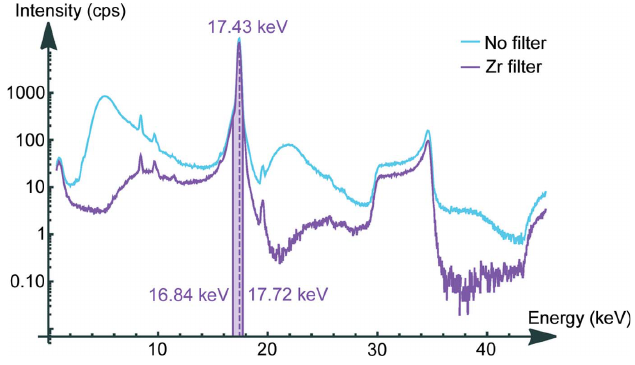
Figure 3 Beam spectrum in logarithmic scale with and without a Zr filter. The marked ROI holds approximately 87% of the total beam intensity. The X-ray tube was operated at 50 kV and 5 mA.